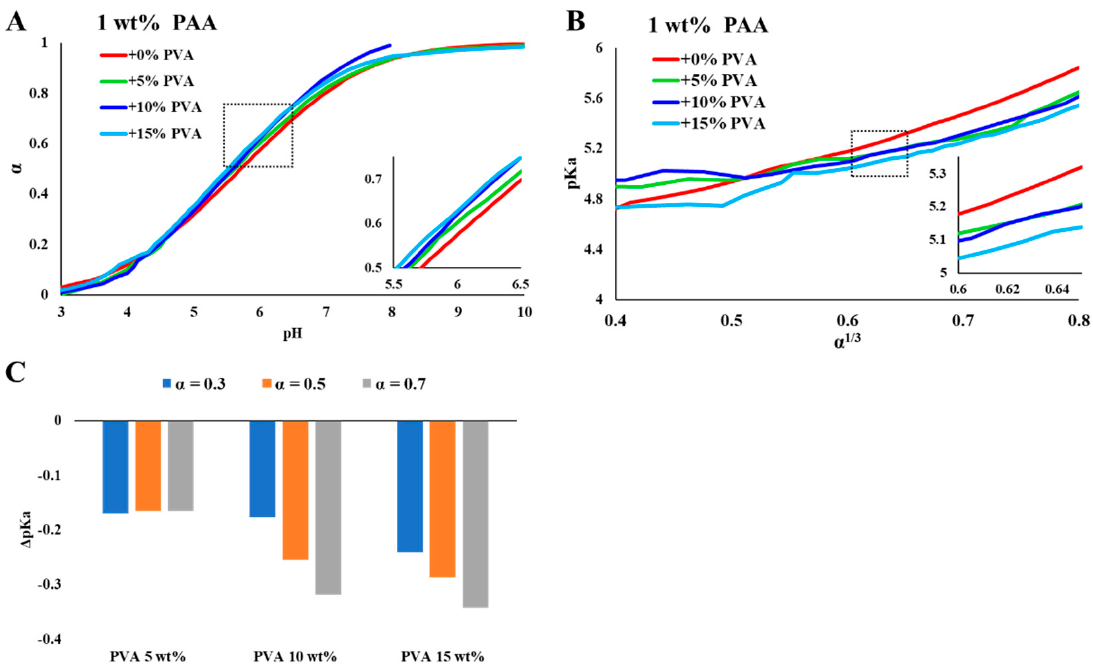
Figure 3. Titration curves of PAA 100 kDa (1 wt%) in PVA solutions. (A) The degree of ionization ( α ) as a function of pH , ( B ) pK a as a function of α 1/3 , ( C ) ∆ pK a (as compared to additive-free PAA solutions) in PVA solutions of 5, 10, and 15 wt%, for α = 0.3, 0.5, and 0.7.